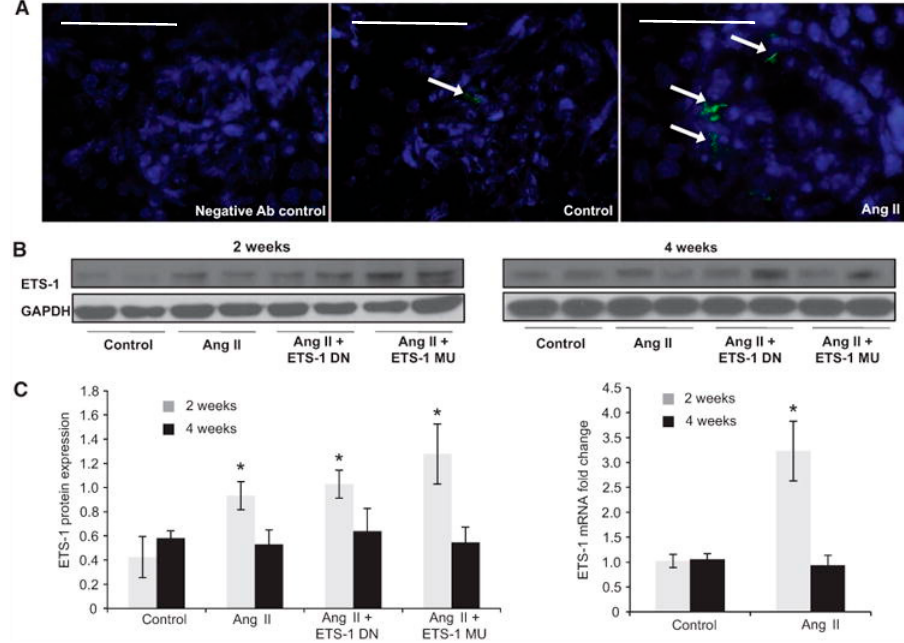
Figure 3. Angiotensin II (Ang II) increases cortical ETS-1 expression. ( A ) Representative confocal photomicrographs showing low basal expression of ETS-1 (green) in control kidney cortex, which is predominantly glomerular and increased by Ang II. (Bar = 50 μ m); ( B ) The renal cortical ETS-1 protein expression increases after 2 weeks of Ang II as assessed by Western blot ( n = 6, * p < 0.05 vs. control) and returns to baseline after 4 weeks of Ang II. The expression of ETS-1 was not significantly modified by treatment with either ETS-1 dominant-negative (ETS-1 DN) or ETS-1 mutant (ETS-1 MU) peptide; ( C ) Densitometric analysis for ETS-1 showing significant increases in ETS-1 protein expression after 2 but not after 4 weeks of Ang II. Neither ETS-1 DN nor ETS-1 MU modified ETS-1 protein expression. Data expressed as mean ± SEM are normalized to GAPDH (* p < 0.05 vs. control; n = 6). The infusion of Ang II for 2 weeks resulted in increases in cortical ETS-1 mRNA expression as assessed by real-time reverse transcriptase polymerase chain reaction ( n = 6; * p < 0.05 vs. control) and returns to baseline levels after 4 weeks of Ang II. GAPDH: glyceraldehyde 3-phosphate dehydrogenase. (Right panel).